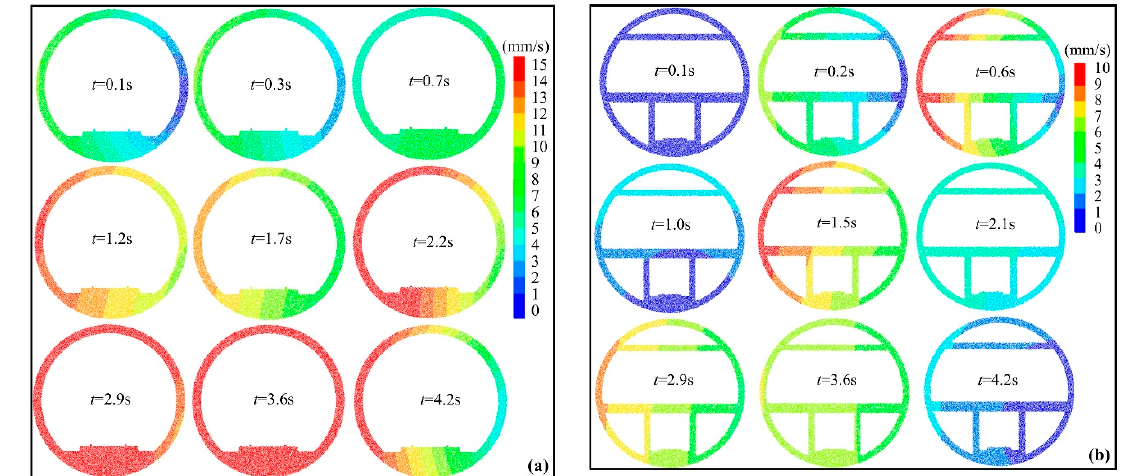
Figure 18. Cloud of the resultant velocity of liner in t2 and T2: ( a ) Resultant velocity of t2 liner at key time points; ( b ) Resultant velocity of T2 liner at key time points.